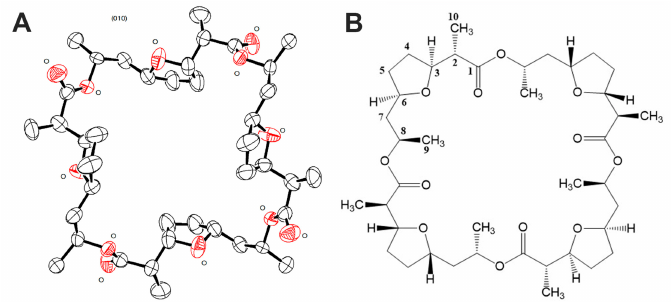
Figure 4. Structure of nonactin obtained as a result of X-ray diffraction analysis ( A ) with view perpendicular to the crystal plane (010). The asymmetric part of the unit cell contains two unbound halves of the molecule. Thermal ellipsoids correspond to 50% probability level. Oxygen atoms are marked with O. Structure formula of nonactin ( B ).